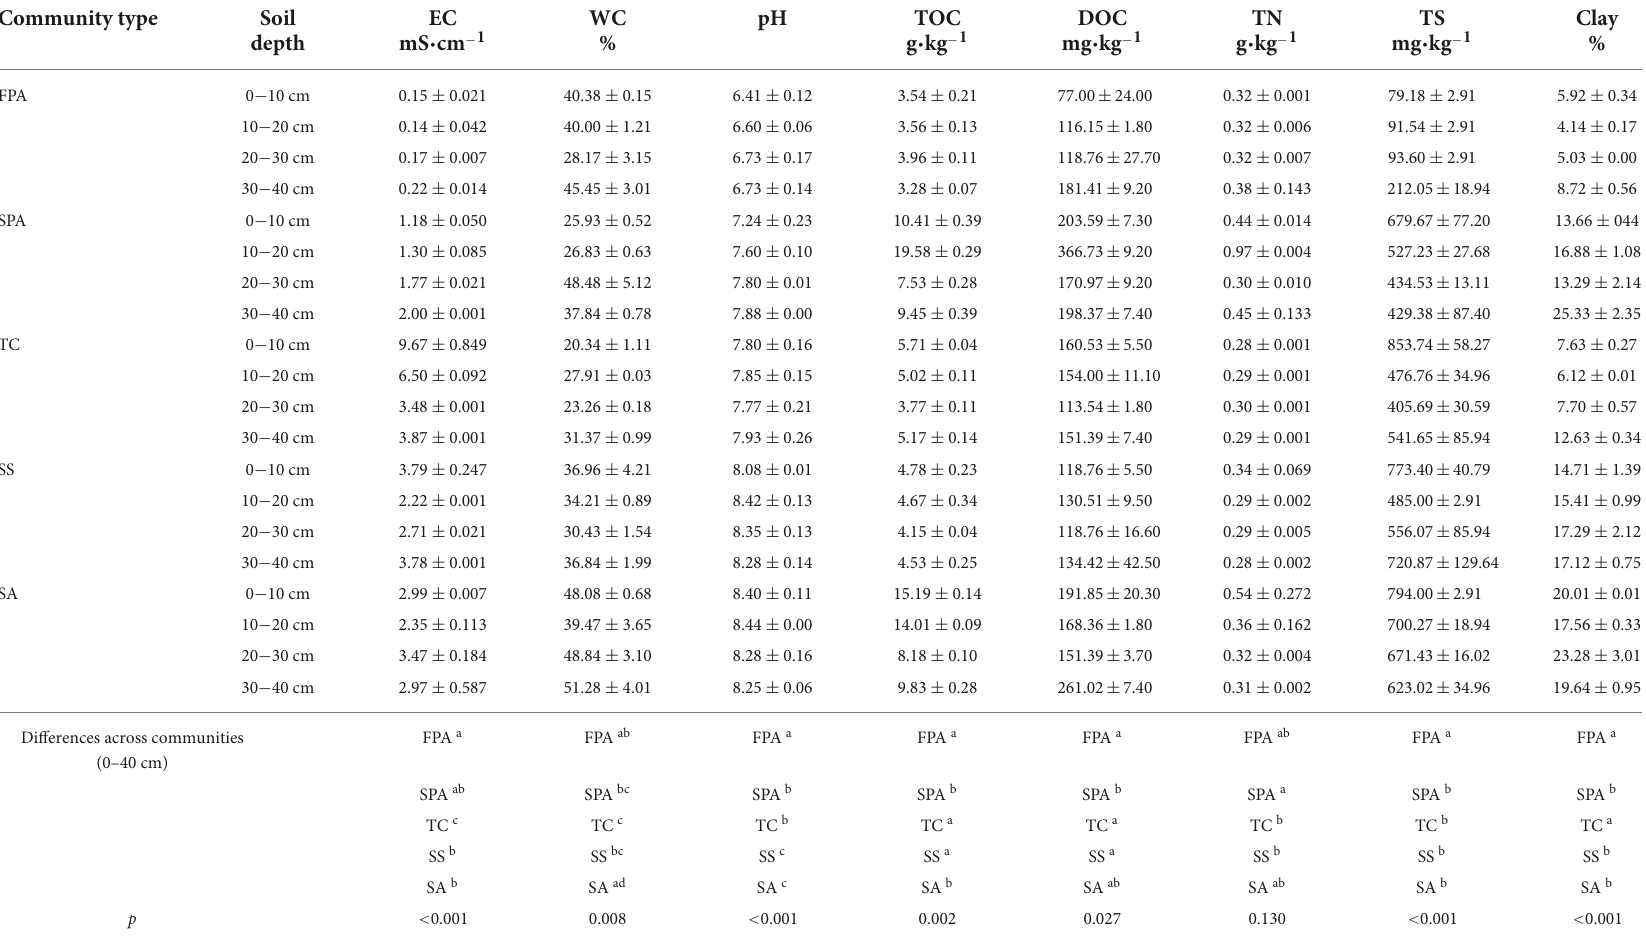
TABLE 1 Soil properties in the different